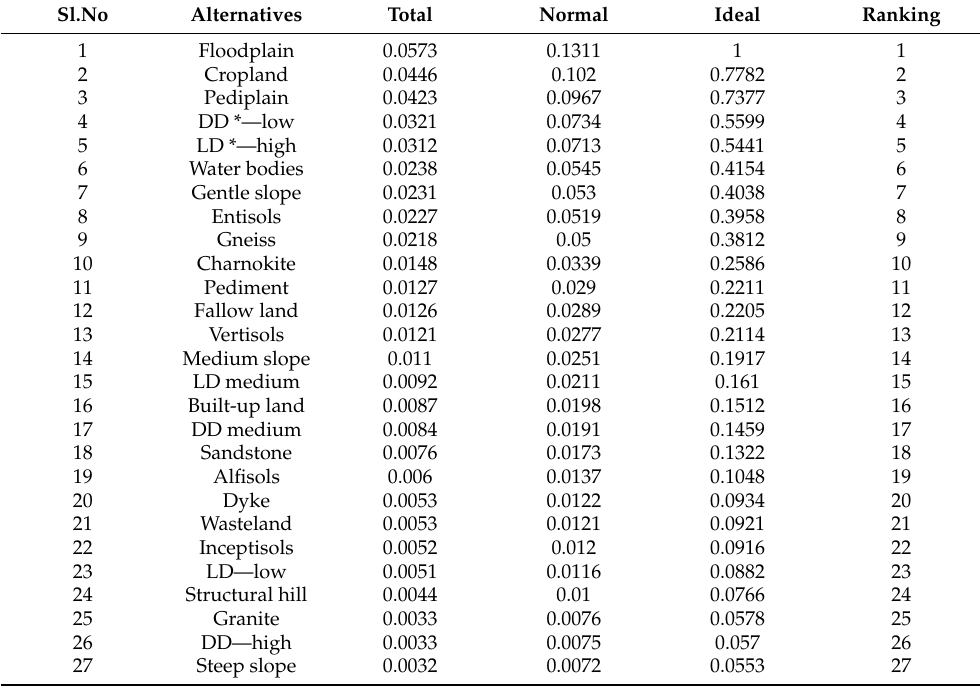
Table 3. Ideal values and overall ranking of surface parameters derived through supermatrix computation.